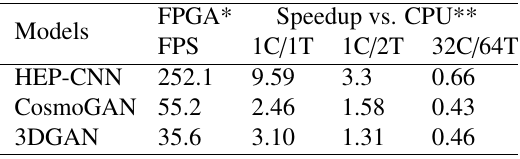
Table 1: Inference performance of case study models with custom OpenVINO